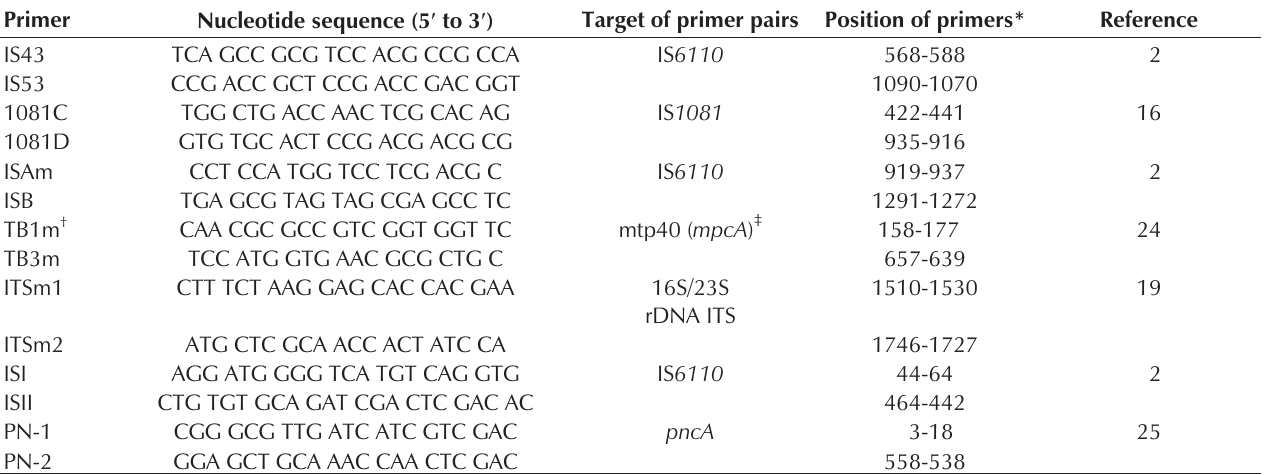
Olignucleotide primers used in analysis of Mycobacterium tuberculosis strain lacking IS 6110 Primer Nucleotide sequence (5 (cid:1) to 3 (cid:1) ) Target of primer pairs